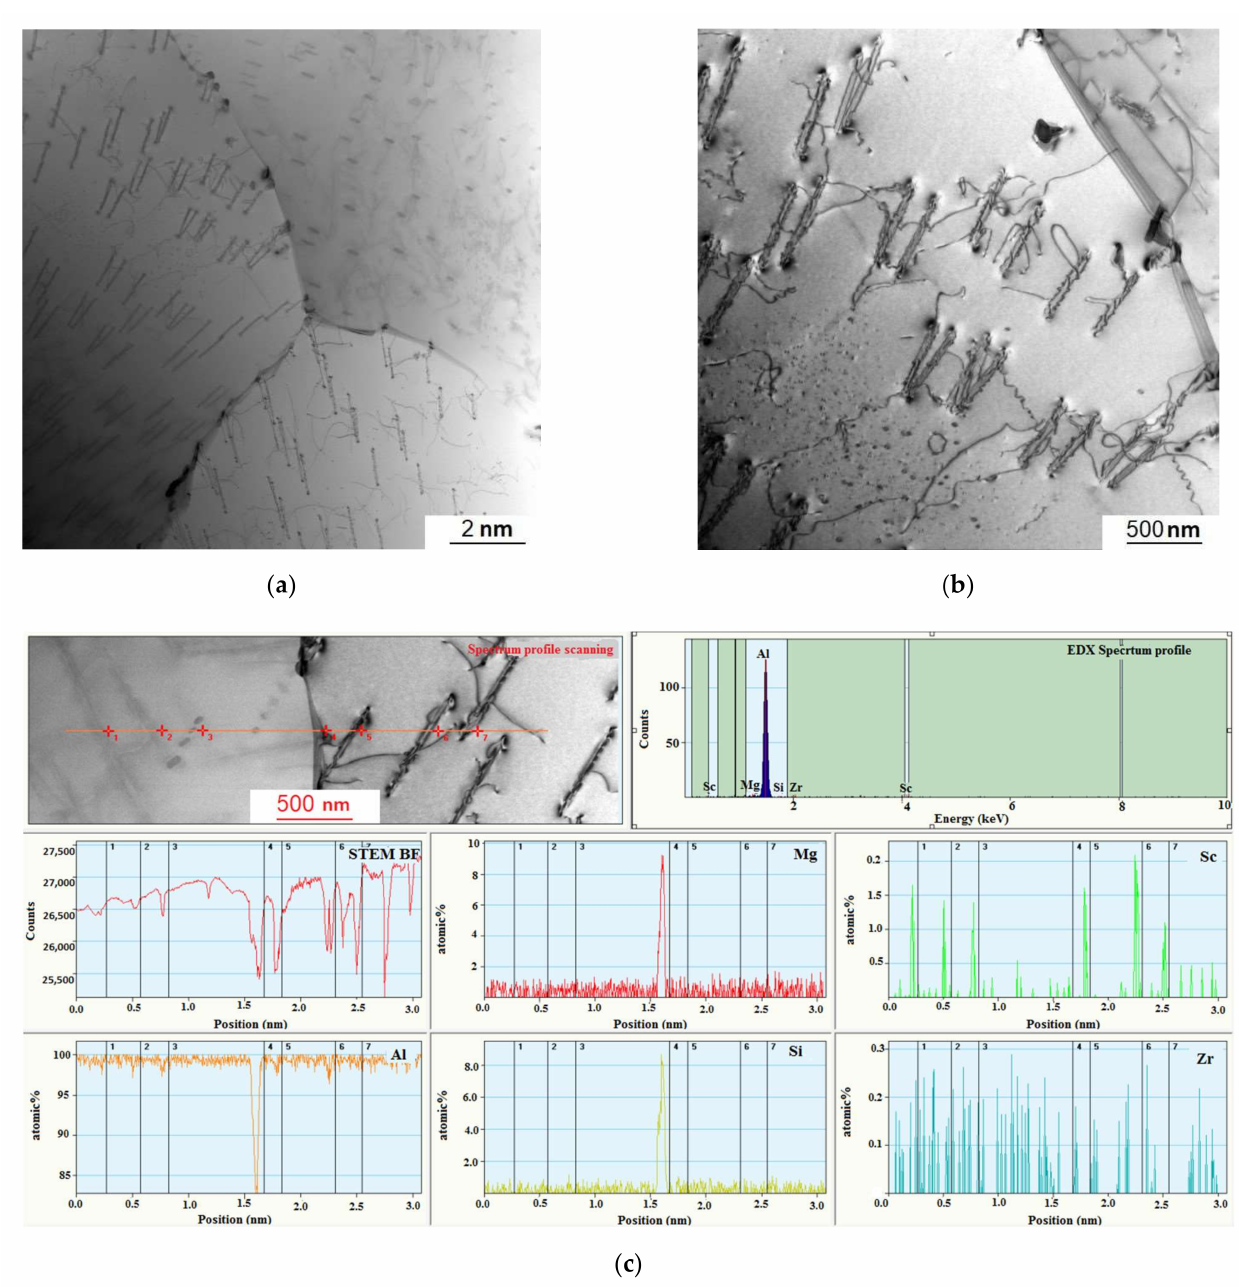
Figure 10. Al 0.3 Mg 1 Si 0.15 Zr 0.3 S copper chill mold ( a ); ( b ) Particles (AlSi) 3 ScZr; ( c ) EDS profile line